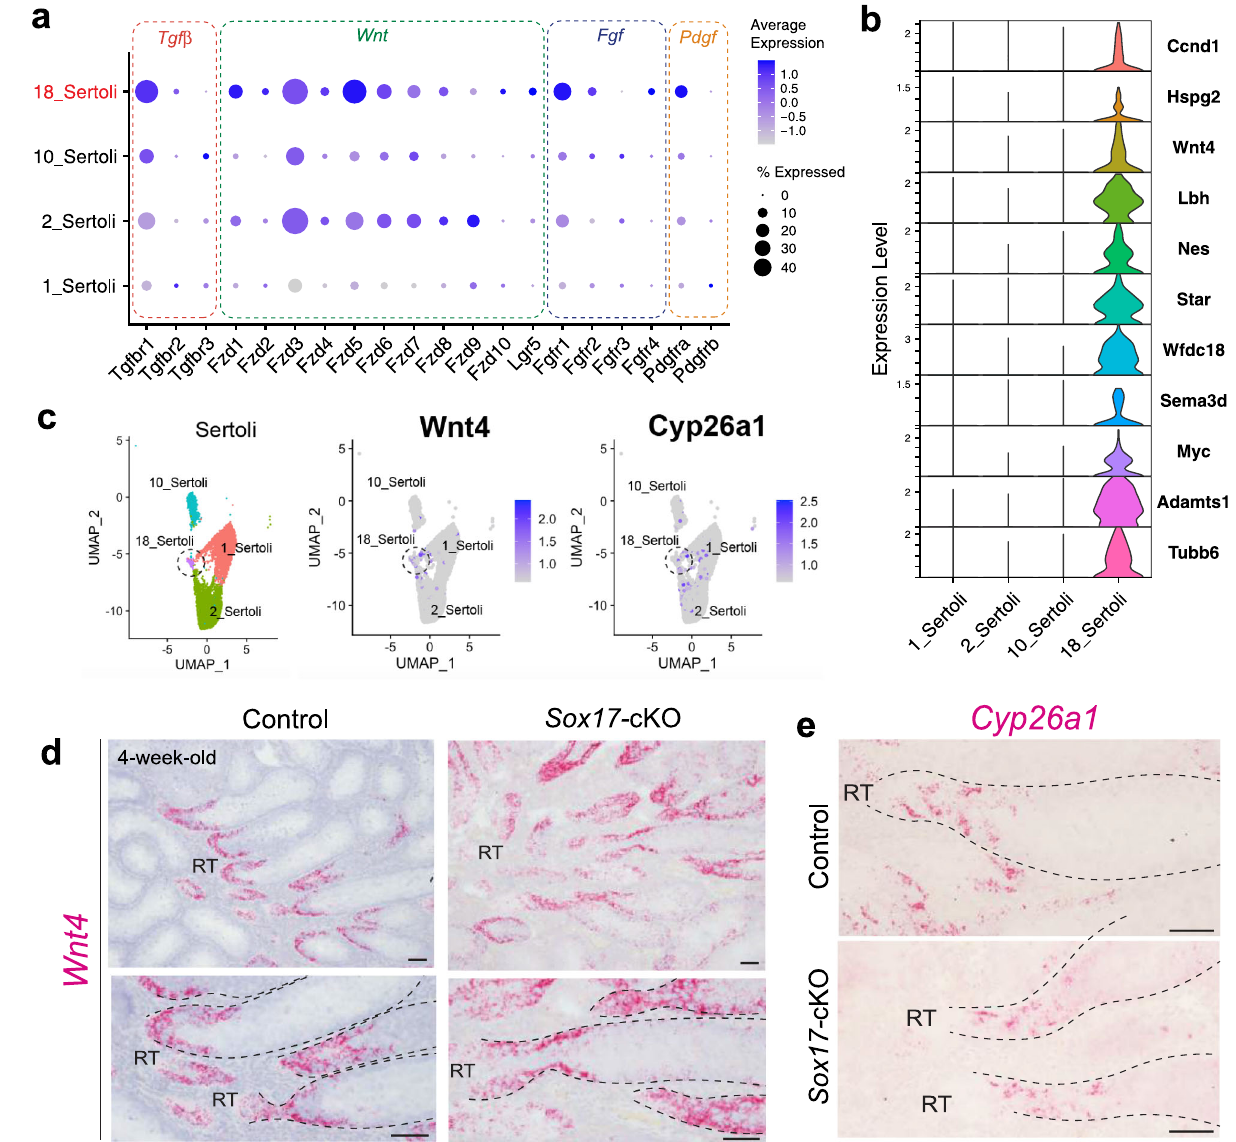
Fig.5|CharacterizationoftheSVSertolicellsinthescRNA-seqdata.a Adotplot representing the expression pro fi les of genes related to the reception of growth factors shown in Fig. 4c, in Sertoli cell clusters. Cluster 18 showed relatively high expression of these receptor genes. b Expression of selected marker genes of cluster 18 represented as violin plots. c UMAP plots showing the distribution of Wnt4 (cluster18maker)and Cyp26a1 (SVmarkerinadult)expressingcellsinSertoli cell clusters. d , e In situ hybridization of Wnt4 , and Cyp26a1 in the presumptive SV